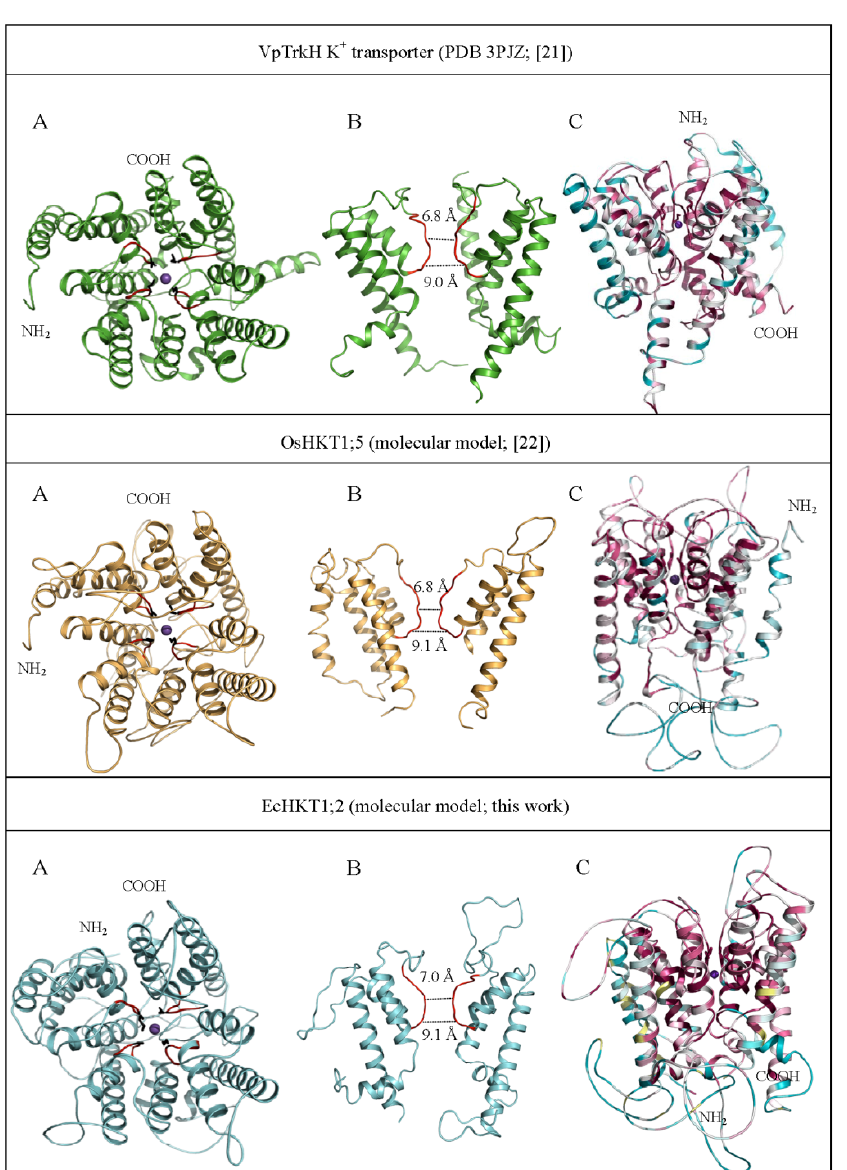
Figure 2. Cartoon representations of 3D structure of VpTrkH (PDB 3PJZ) (top panels) and molecular models of the Oryza sativa OsHKT1;5 (middle panels) and Eucalyptus camaldulensis EcHKT1;2 (bottom panels) transporters. ( A ) The overall folds of transporters are coloured in green (VpTrkH) orange (OsHKT1;5) and cyan (EcHKT1;2). Purple spheres indicate the K + (VpTrkH) and Na + (OsHKT1;5 and EcHKT1;2) ions. The selectivity filter signatures illustrated in black sticks are: Gly-Gly-Gly-Gly for VpTrkH and Ser-Gly-Gly-Gly for OsHKT1;5 and EcHKT1;2. The residues contained in the selectivity pores are coloured in red. These residues are likely to affect pore rigidity and dispositions of residues controlling cation selectivity and transport rates; ( B ) The cut-out images show geometry of selectivity pores. Their width dimensions are indicated; ( C ) Cartoon representations of VpTrkH, OsHKT1;5 and EcHKT1;2 colour-coded by conservation score of amino acid residues as predicted by ConSurf [81]. The views in panels C are rotated by 90° along the x -axis with respect to the views in panels A. The NH - and COOH-termini of 2 the transporters are